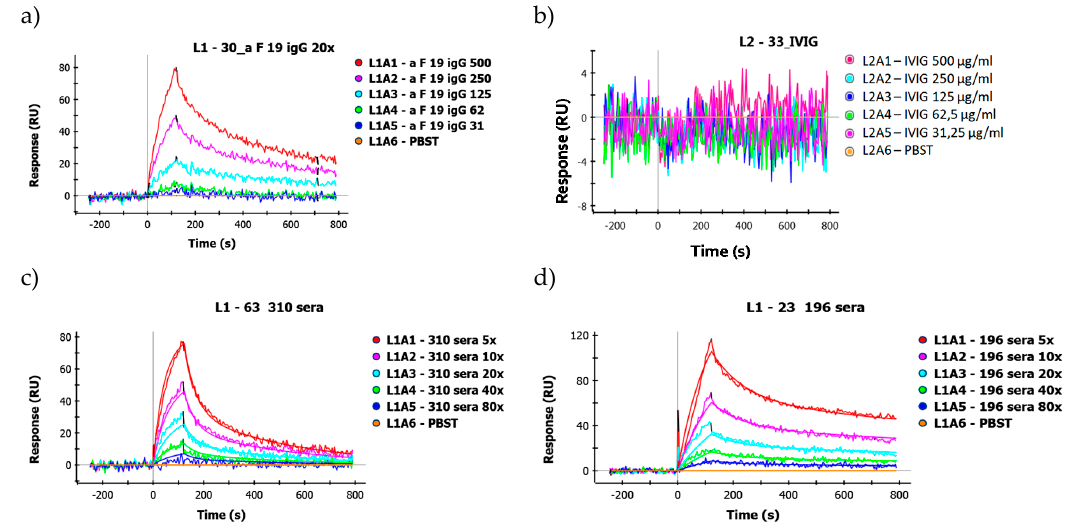
Figure 4. Representative sensograms of: ( a ) Cit-filaggrin19-affinity purified IgG; ( b ) negative control IVIG; and two typical sera with: ( c ) higher; and ( d ) lower affinity on Cit-filaggrin19 coupled GLH chip.